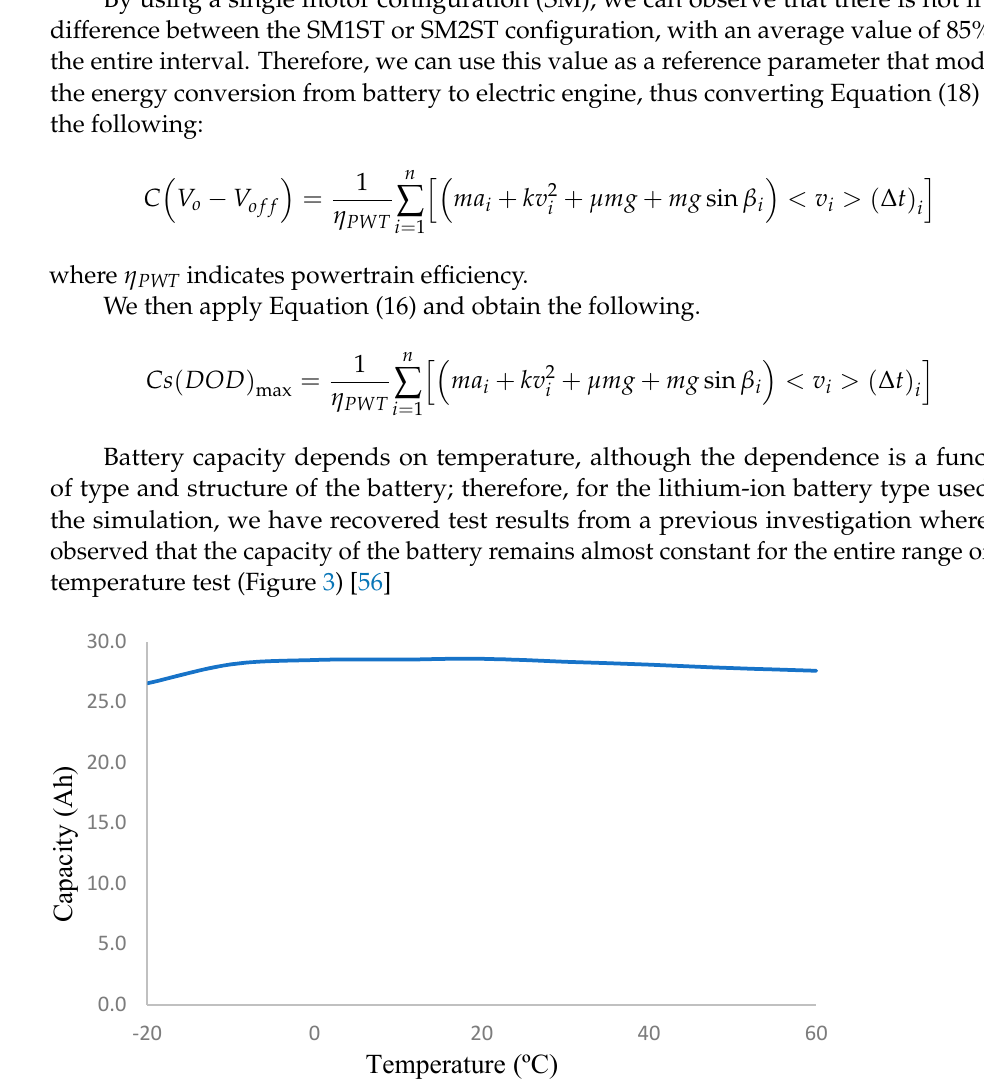
Figure 3. Evolution of simulated battery type with temperature.